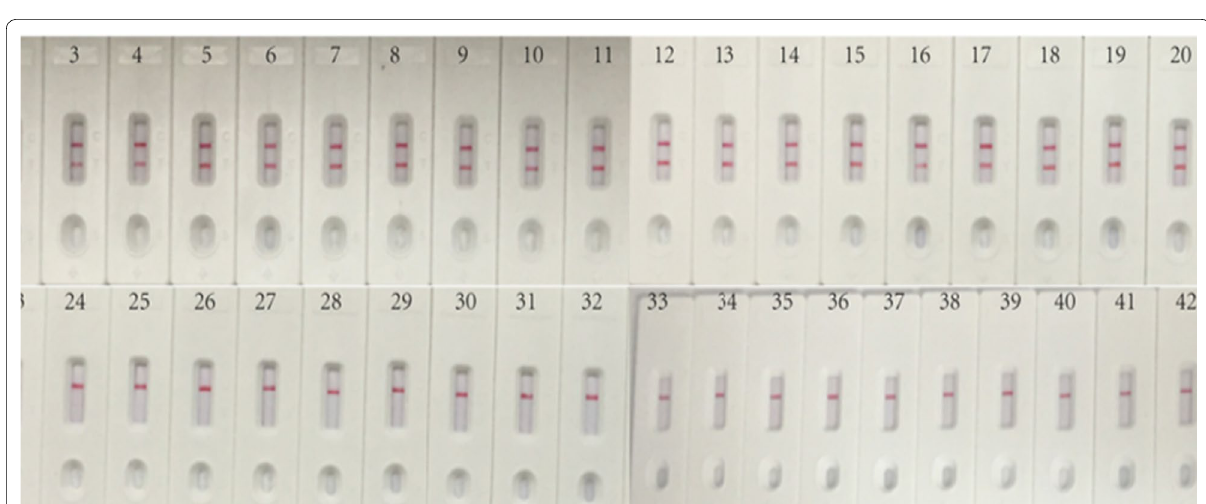
Fig. 6 Specificity of LFB assays detecting A. baumanni -MCDA products. Different genomic DNA templates extracted from 43 strains were analyzed by MCDA-LFB assays. Two red lines were visuable in LFB for all A. baumannii, and only the control line was observed in non- A. baumannii . 1, Positive control ( A. baumannii ATCC19606), 2–21, isolated A. baumannii strains. 22, Acinetobacter nosocomialis ; 23, Acinetobacter pittii ; 24, Acinetobacter lwoffii ; 25, Pseudomonas aeruginosa THH-PA001; 26, klebsiella pneumoniae ATCC700603; 27, Haemophilus influenza ; 28, Haemophilus parahaemolyticus ; 29, Mycobacterium tuberculosis ATCC25177; 30, Neisseria meningitides ATCC13090; 31–32, Streptococcus pneumoniae ; 33, Staphylococcus aureus ; 34 , Staphylococcus epidemidis ; 35, Staphylococcus saprophyticus ; 36 , Vibrio cholera; 37, Salmonella ; 38, Listeria monocytogenes ATCC51779; 39, Enterohemorrhagic E. coli ; 40, Enteropathogenic E. coli ; 41, Enterotoxigenic E. coli ; 42, Enteroaggregative E. coli ; 43, Enteroinvasive E.